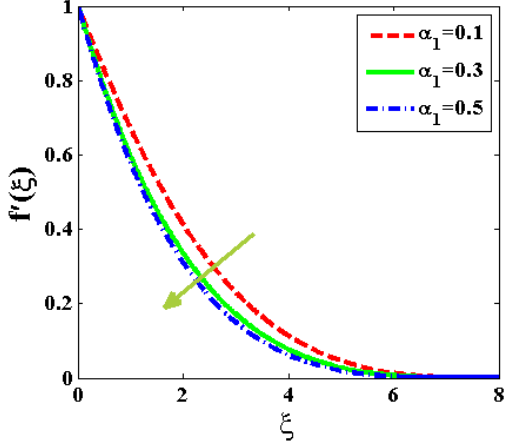
Figure 4. Outlines of 𝑓 ′ at diverse quantities of 𝛼 (cid:2869) .